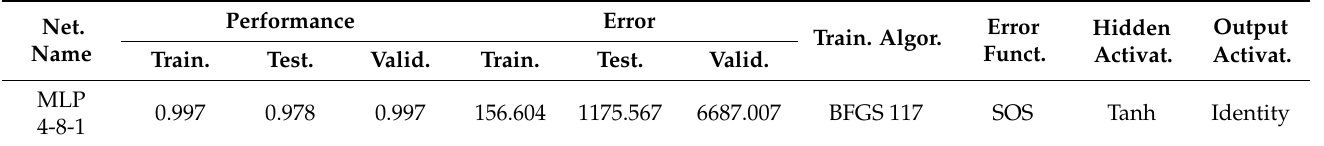
Table 3. ANN model summary (performance and errors), for training, testing, and validation cycles.